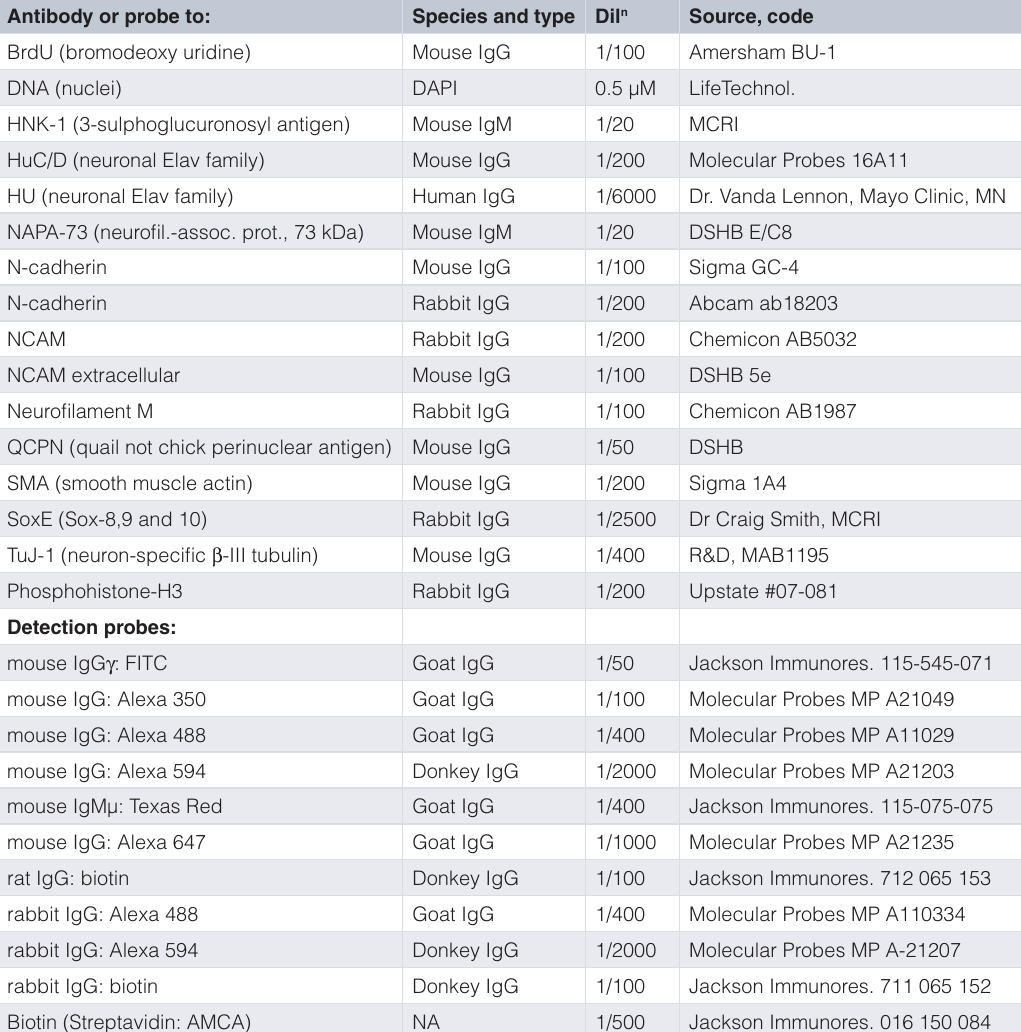
Supplementary Table T1. Antibodies and fluorescent